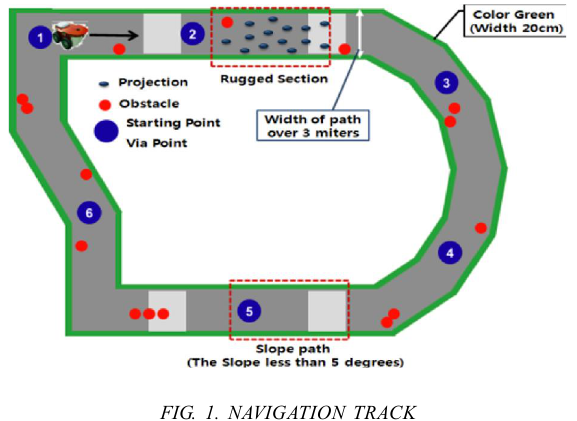
FIG. 1. NAVIGATION TRACK